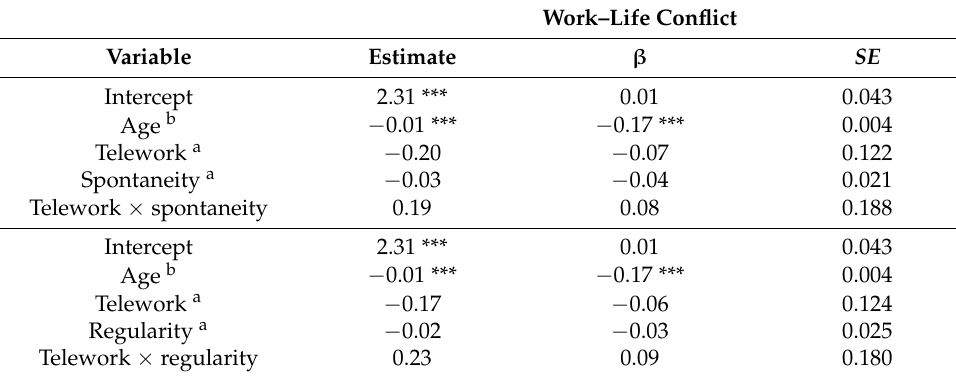
Table 2. Moderation effects of qualitative aspects of telework on work–life conflict.